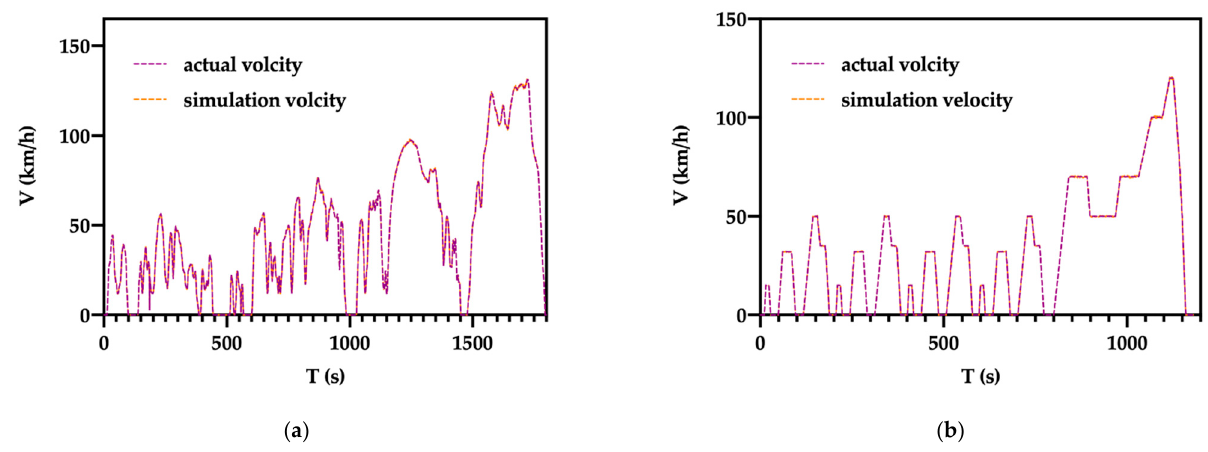
Figure 6. The comparison of the co-simulation model speed and real vehicle speed: ( a ) under the WLTC (Worldwide Light-Duty Test Cycle); ( b ) under the NEDC (New European Driving Cycle).